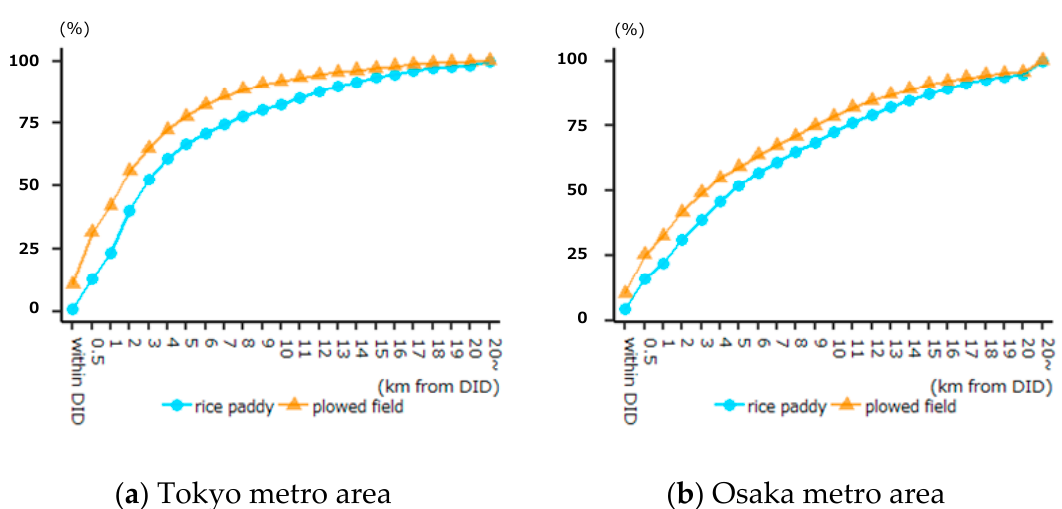
Figure 5. Cumulative percentage of total areas by distance from DID. ( a ) shows the case of Tokyo metro area and ( b ) shows the case of Osaka metro area.